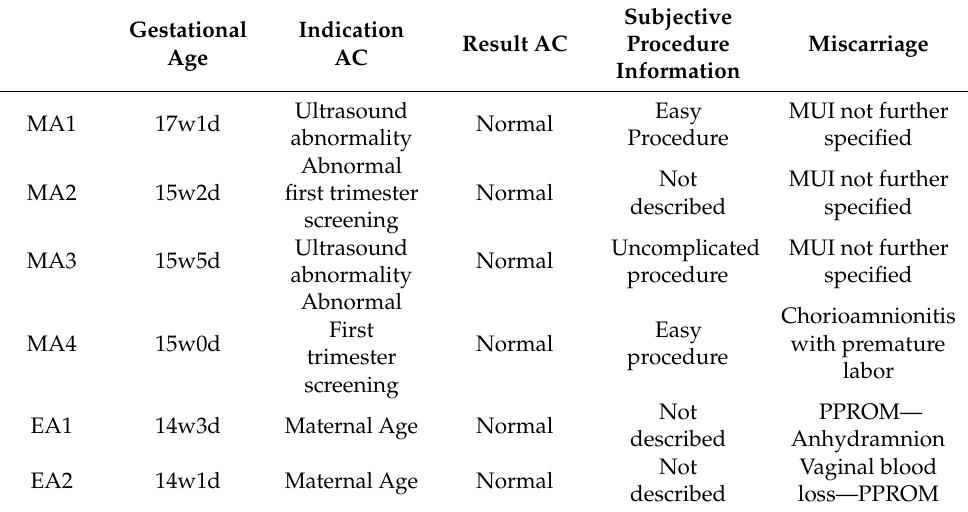
Table 4. Procedure-related